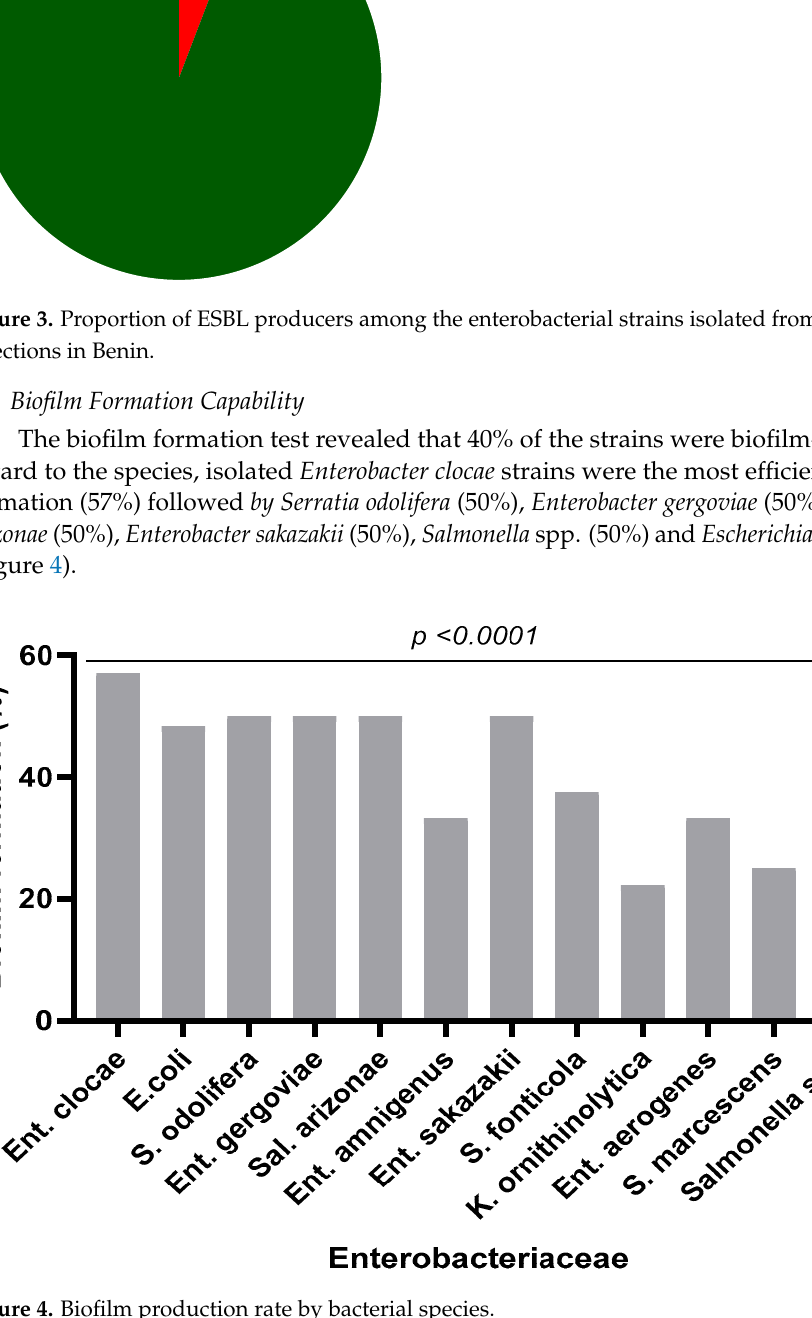
Figure 4. Biofilm production rate by bacterial species.